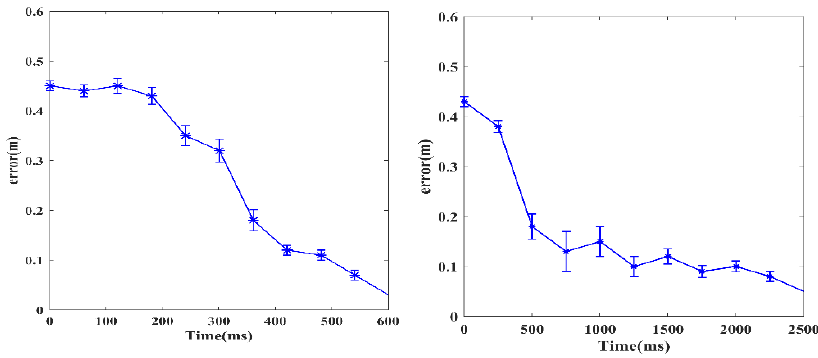
Figure 14. Error bars of 0.1 m/s ( left ) and 0.25 m/s ( right ).